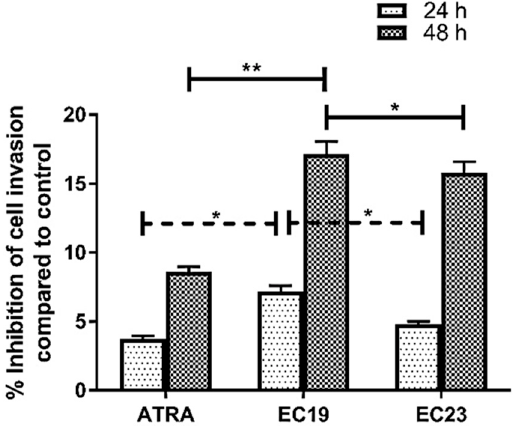
Figure 4. The percentage inhibition of Caco-2 cell invasion after the treatment with retinoids in comparison to the solvent control. The stain of invasive cells that traversed the membrane was extracted using the kit’s extraction buffer and quantified at 490 nm using a microplate reader. The percentage reduction in absorbance (and thus invasion) by retinoids was calculated, in comparison to the DMSO-treated control, and plotted as mean ± SEM of three independent experiments. The most significant reduction was observed with EC19 after 24 h and 48 h compared to ATRA and EC23. The significance in p- values for comparison is indicated as * p < 0.05, ** p < 0.01.